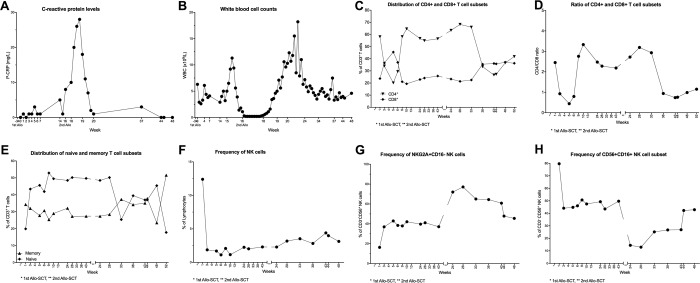
Clinical and immunological parameters from a patient who received Allo-SCT and dara treatment.(A-B): The laboratory parameters CRP (A) and WBC at admission during the Dara treatment are shown. (C-H) Peripheral blood samples were collected from patients throughout the Dara treatment. PBMCs were stained with lymphoid lineage markers and analyzed by flow cytometry, as described in experimental procedures. Frequencies of T cell and NK cells subsets are depicted. (C) percentages of CD8+ and CD4+ T cells and (D) CD4/CD8 ratio during Dara treatment (E) distribution of memory (CD45RA-CD45RO+) and naïve (CD45RA+CD45RO-) T cell subpopulation. In (F), total CD3-CD56+ NK cells as the percentage of lymphocytes and (G) CD56+CD16-NKG2A+ NK cells as the percentage of CD3-CD56+ NK cells are shown. (H) shows frequency of CD56+CD16- as the percentage of total CD3-CD56+ NK cells.